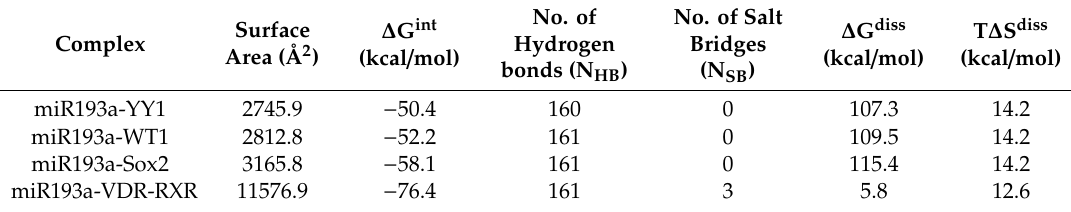
Table 1. DNA-Transcription factor interaction.